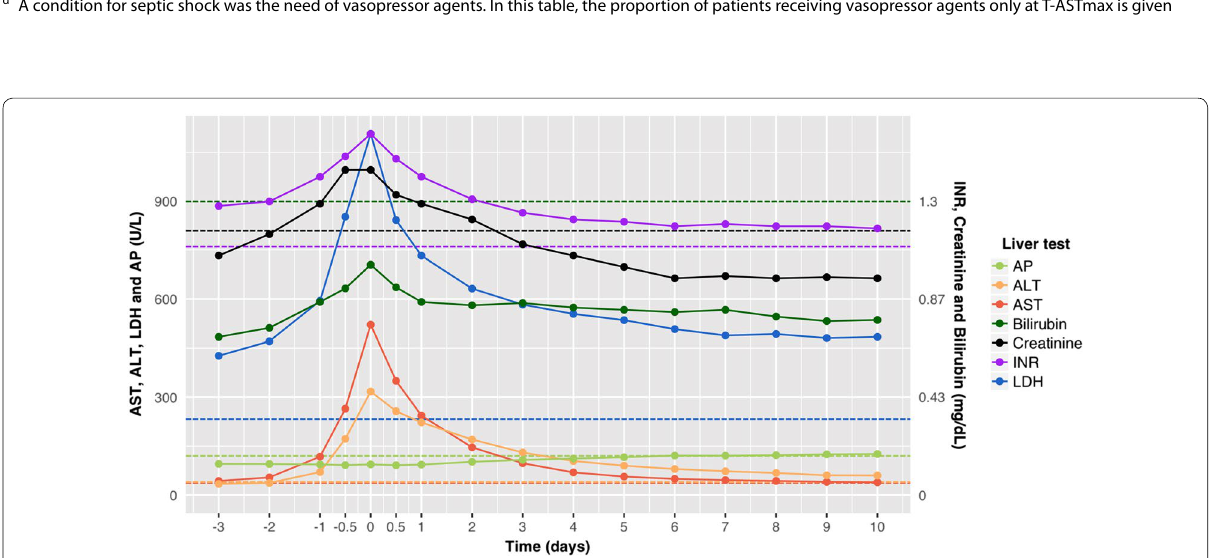
Fig. 3 Time trend of liver tests in hypoxic hepatitis. Time trend of the median AP, ALT, AST, bilirubin, creatinine, INR and LDH levels in hypoxic hepa- titis. T-ASTmax is designated as time 0. AST, ALT, LDH and AP levels are measured in U/L and are plotted using the left y -axis. Bilirubin and creatinine levels are measured in mg/dL and plotted using the right y-axis. INR has no unit, but is also plotted using the right y -axis. AP alkaline phosphatase, ALT alanine aminotransferase, AST aspartate aminotransferase, INR international normalized ratio, LDH lactate